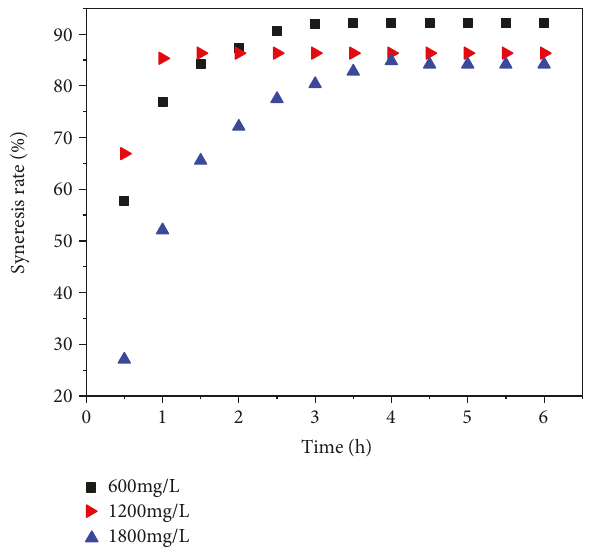
Figure 7: The syneresis rate of emulsion under di ff erent content of polymer.